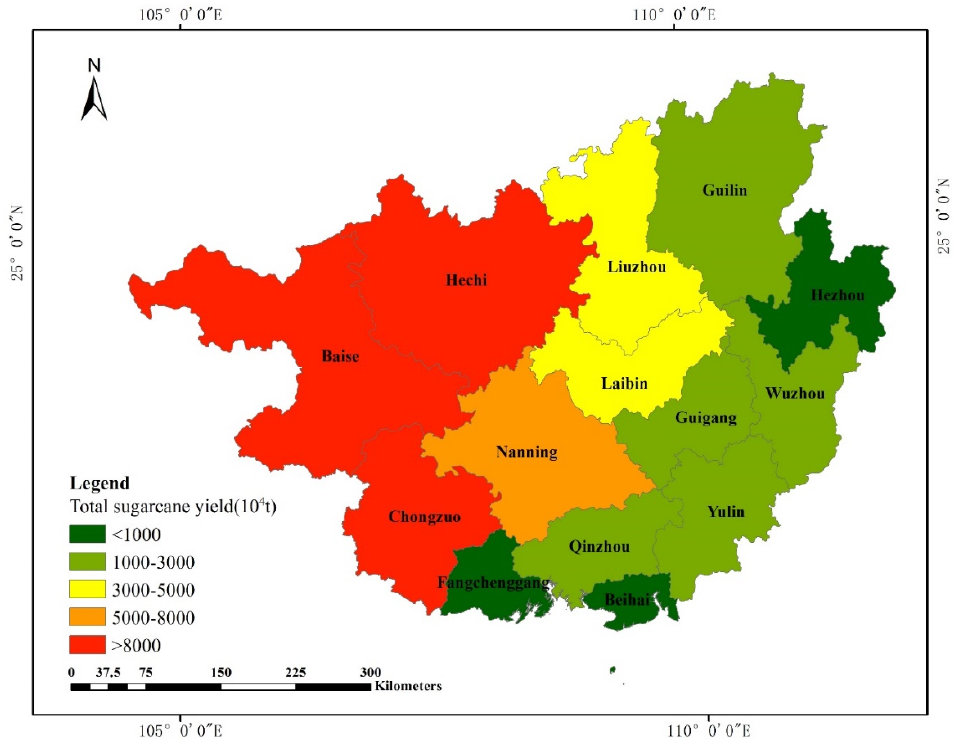
Figure 9. Total sugarcane yield in the Guangxi Zhuang Autonomous Region.